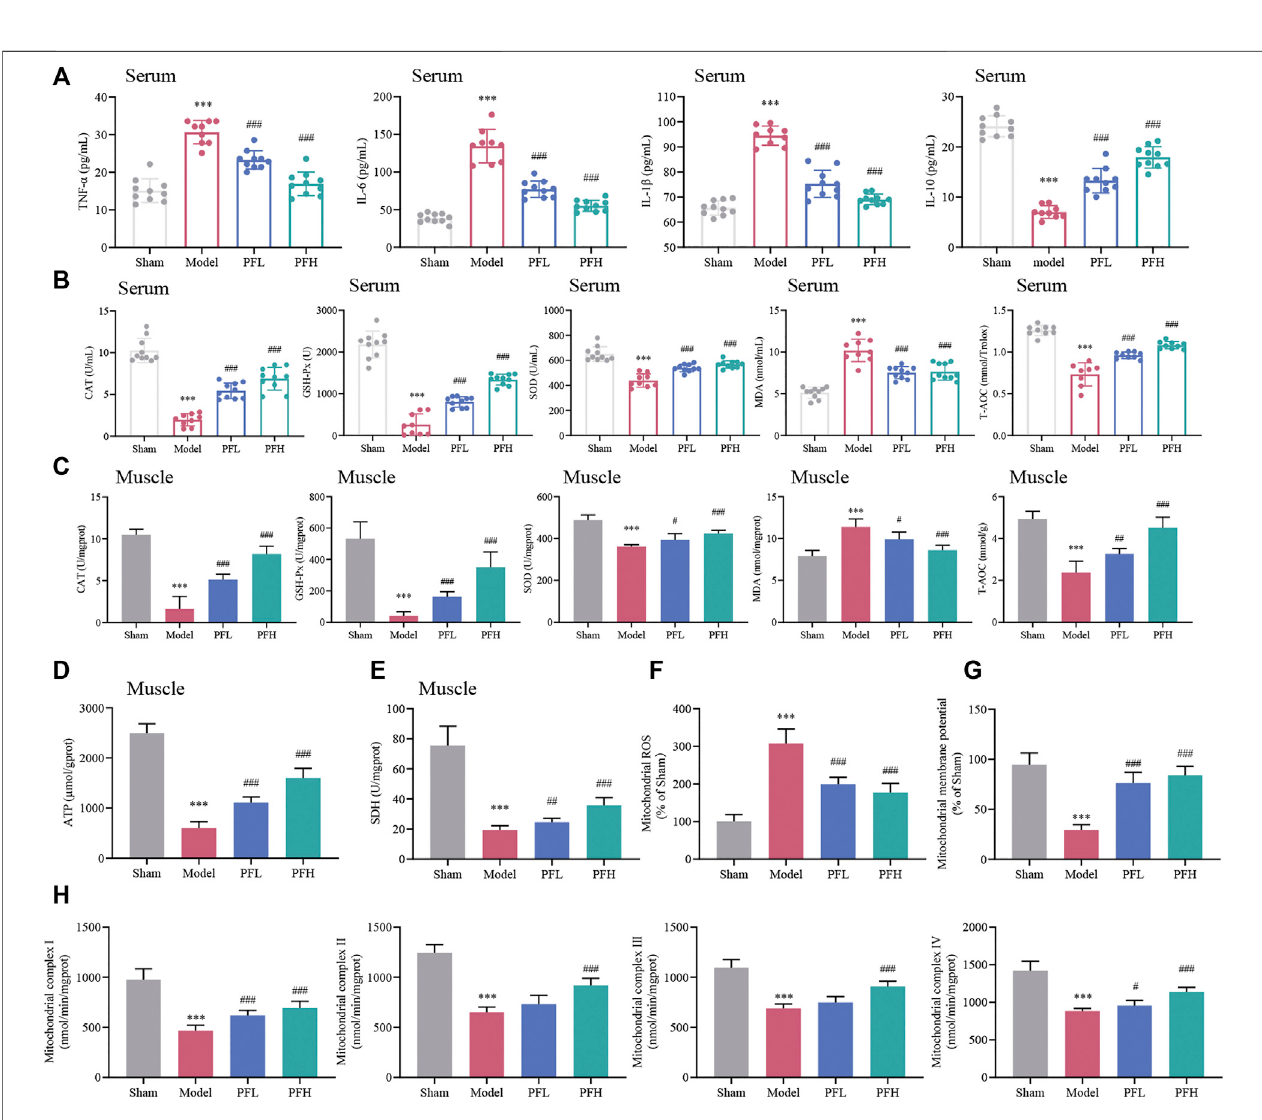
FIGURE 3 | Effectof PF on in fl ammation, oxidative stress and mitochondrial dysfunction in CKD rats. (A) Expression of the in fl ammatory cytokines TNF- α , IL-6, IL- 1 β and IL-10 in serum. (B, C) CAT, GSH-Px, SOD, MDA and T-AOC contents in serum and muscles of different groups are presented in the histograms. (D, E) The expression of ATP and SDH in muscles. (F) PF inhibited mitochondrial reactive oxygen species (ROS) generation in muscles. (G) The effects of PF on mitochondrial membrane potential ( Δψ m) in muscles. (H) The activities of mitochondrial electron transport chain complexes I, II, III and IV in muscles between groups. All of the data are expressed as the means ± S.Ds. n = 6. Signi fi cant differences are indicated as * p < 0.05, ** p < 0.01, *** p < 0.001 vs. the Sham group. # p < 0.05, ## p < 0.01, ### p < 0.001 vs. the Model group.